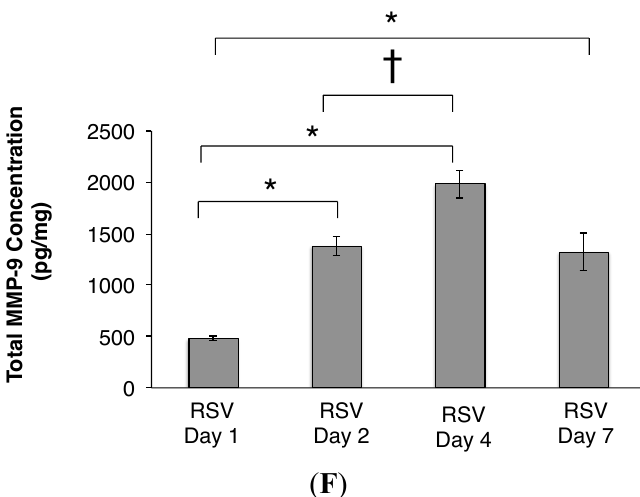
Figure 1. ( A ) RSV titer is increased in infected HBE cells over time. 16HBE cells were permissive to RSV infection, with increasing viral titer detected over time. At 24 h PI, the RSV titer was 3.2 ± 0.1 log PFU/mL, which increased to 4.4 ± 0.2 and 4.7 ± 0.1 log 10 10 PFU/mL, respectively, on days 2 and 4 PI. By day 7 PI, the RSV titer was approximately 1–2 logs higher compared to the 24 h and 48 h time point. Data represent mean ± SEM. * p < 0.001 and † p = 0.003 as indicated, by ANOVA followed by Tukey-Kramer multiple comparisons test; ( B ) RSV infection is a potent stimulus of MMP-9 mRNA expression. MMP-9 mRNA was four-fold higher in the RSV infected HBE cells (MOI = 1)